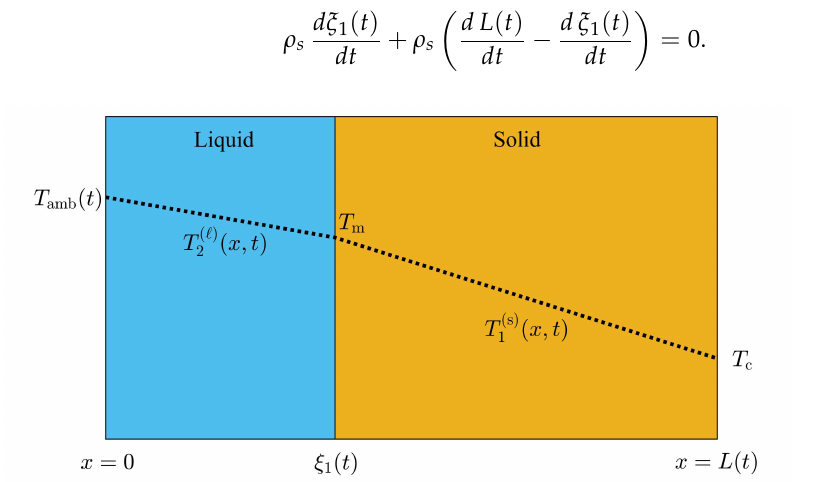
Figure 1. Schematic representation of the PCM layer in the presence of one liquid–solid interface or front with the temperature profiles in the liquid phase (region 2) and solid phase (region